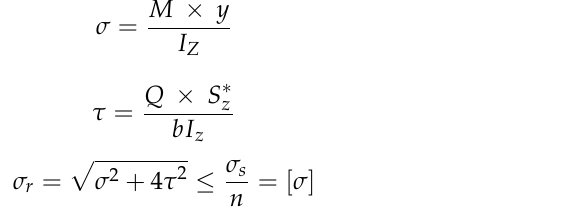
Figure 6. Cutting force acting on the tool.